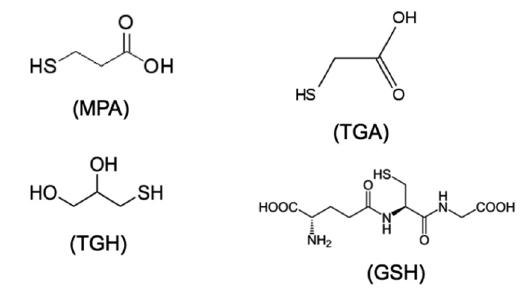
Figure 1: Structure of the capping agents: 3-mercaptopropionic (MPA), thioglycolic acid (TGA), thioglycerol (TGH), and glutathione